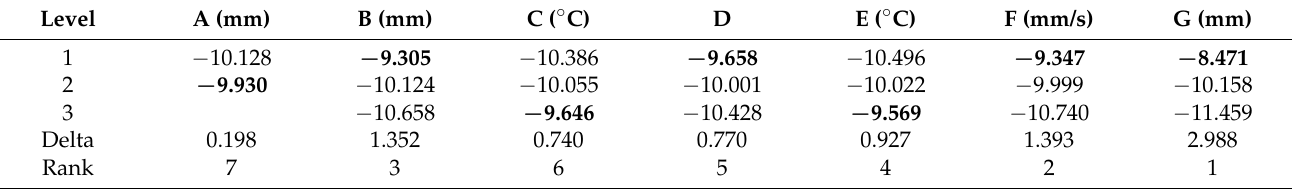
Table A1. Mean S/N ratio response table for Ra-ABS polymer.